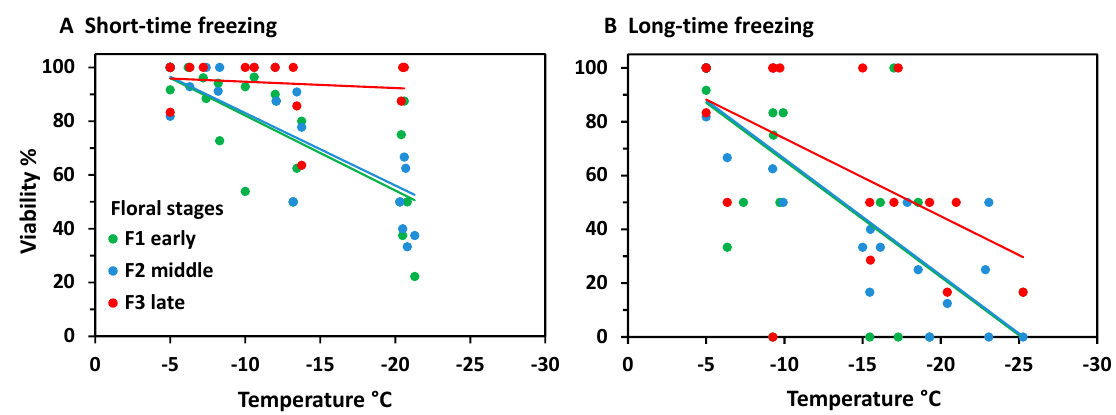
Figure 8. Saxifraga bryoides L. Percent viability (TTC test) of floral winter buds in early (green), middle (blue) and late (red) developmental stages after ( A ) short-time and ( B ) long-time exposure at different freezing temperatures in experiment 2. For floral stages see Figure 6. Each symbol refers to a single individual. Data at − 5 °C are control values of the respective stage. Trend lines indicate linear regressions.